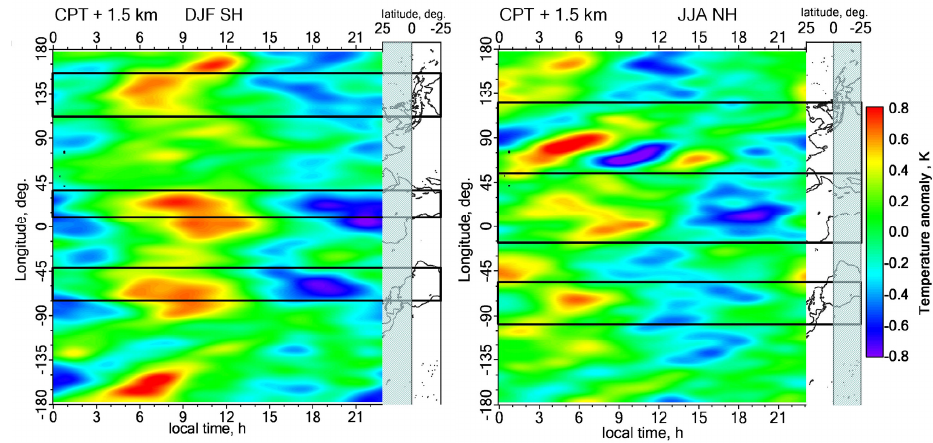
Fig. 4. Geodiurnal variation of temperature anomaly between 0–25 ◦ S and 0–25 ◦ N during the local summer in DJF (left) and JJA (right) in a 1.5km-thick layer above the local CPT. Land areas are enclosed in black rectangles corresponding to the continent limits shown on the maps on the right of the diagrams.